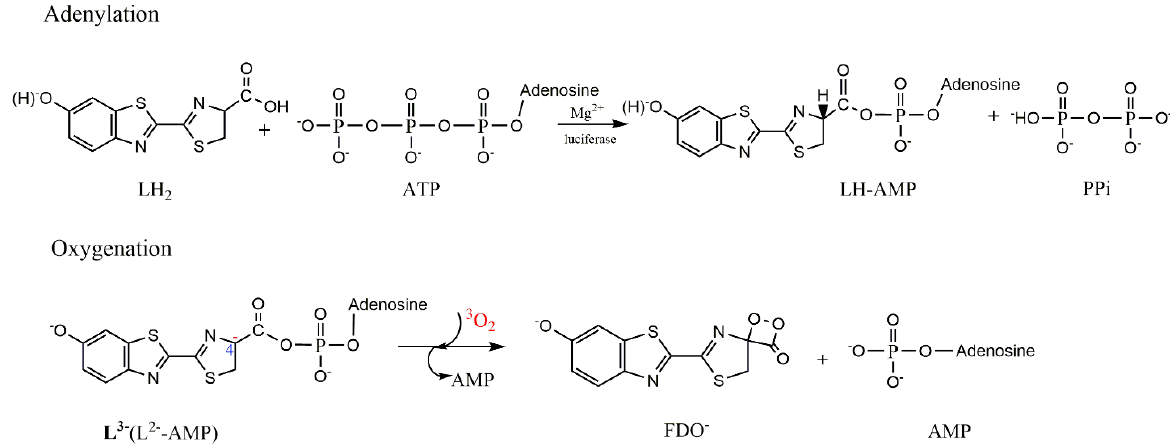
Scheme 1. Two half reactions (adenylation and oxygenation) in the initiation of firefly bioluminescence.